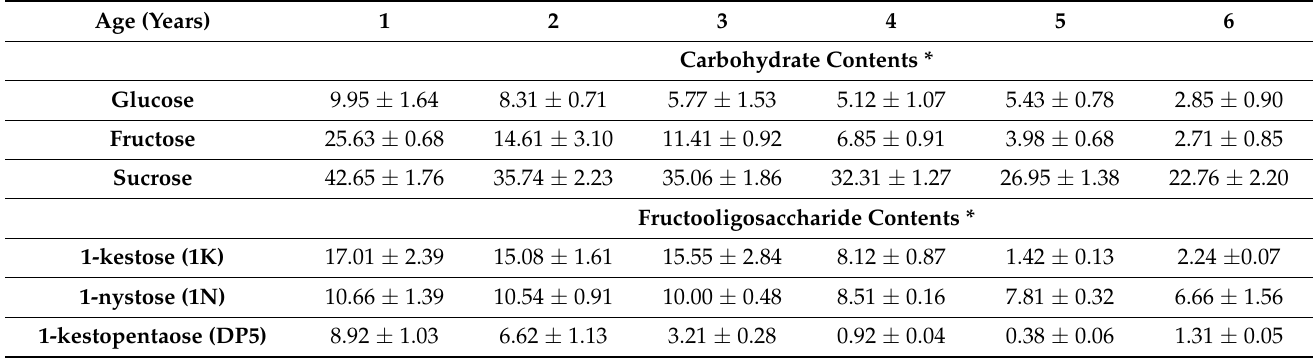
Table 2. Carbohydrate and fructooligosaccharide content of A. angustifolia Haw. plants at different ages.